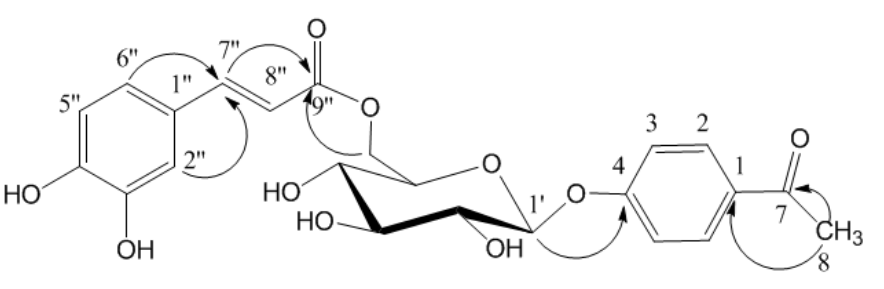
Figure 1 . Important HMBC correlations of 1